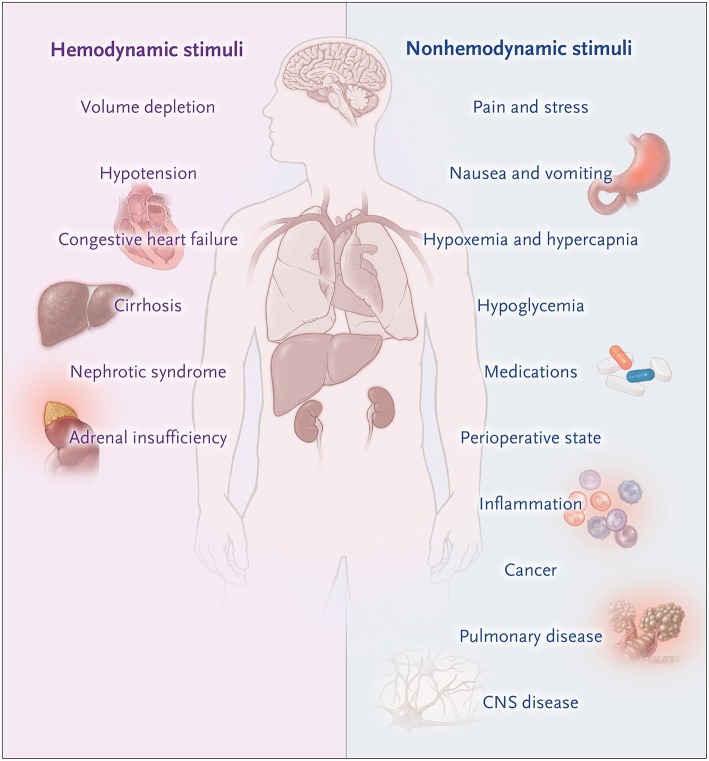
Non-osmotic states of AVP excess. Moritz and Ayus (24).